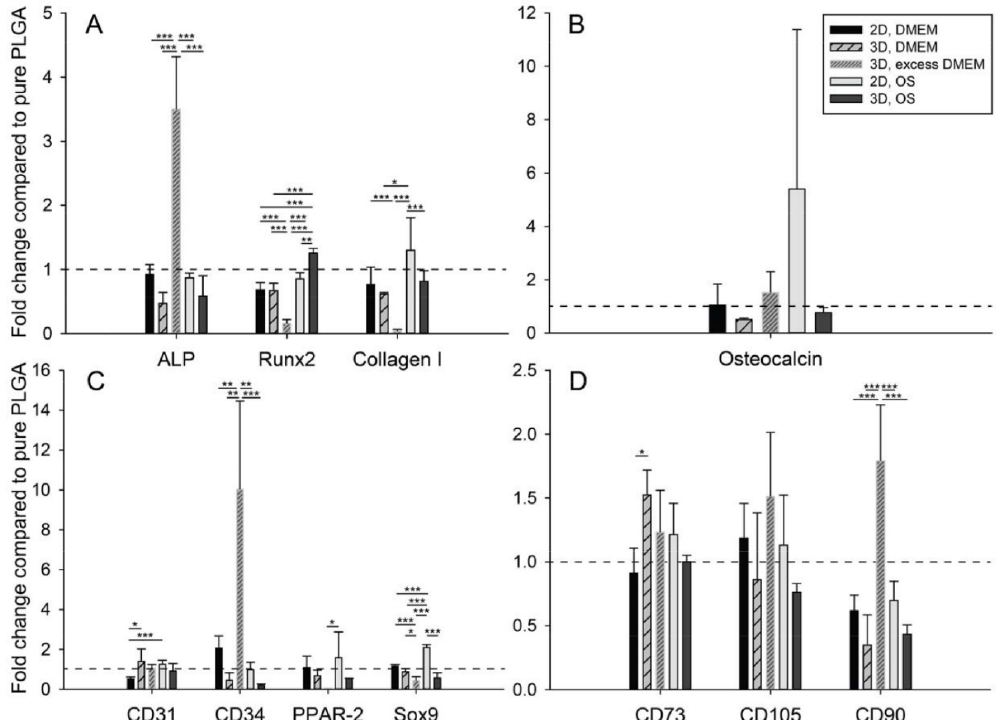
Figure 3. Manifold gene expression of human adipose-derived stem cells (ASCs) seeded on PLGA or on PLGA/aCaP realized as casted films or as electrospun random fiber meshes. The fold change of aCaP-seeded PLGA compared to pure PLGA is shown in ( A ) ALP, Runx2 and collagen I, ( B ) osteocalcin, ( C ) CD31, CD34, PPAR- γ -2 and Sox9, ( D ) CD 73, CD105 and CD 90. Values at 1.0 (dashed line) indicate no change in gene expression, whereas higher values indicate enhanced gene expression if aCaP nanoparticles are present. Key: OS = osteogenic medium. The p -values of pairwise comparison of one-way ANOVA statistics were considered significant if p < 0.05, denoted by *. **, p < 0.01; ***, p < 0.001. For significant differences between PLGA / aCaP and PLGA, we refer to SI Figures S1 and